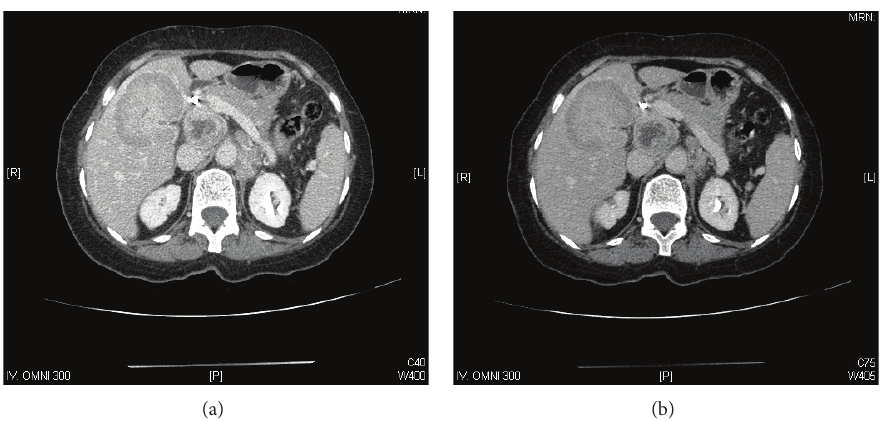
Figure 1: Prechemotherapy abdominal computed tomography (CT) showing (a) a large 7.9 × 5.1cm heterogeneous mass involving the gallbladder and the adjacent liver and (b) enlarged portocaval and para-aortic lymph nodes.